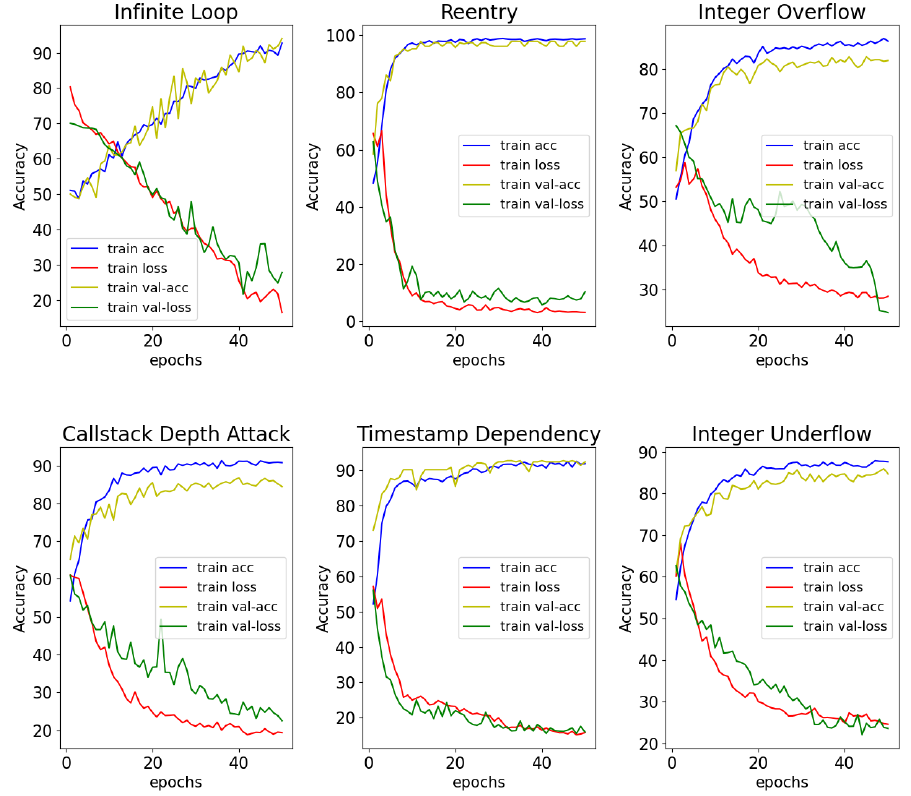
Figure 9. Plots of Acc-Loss. Table 4. Performance comparison of a single model and serial hybrid